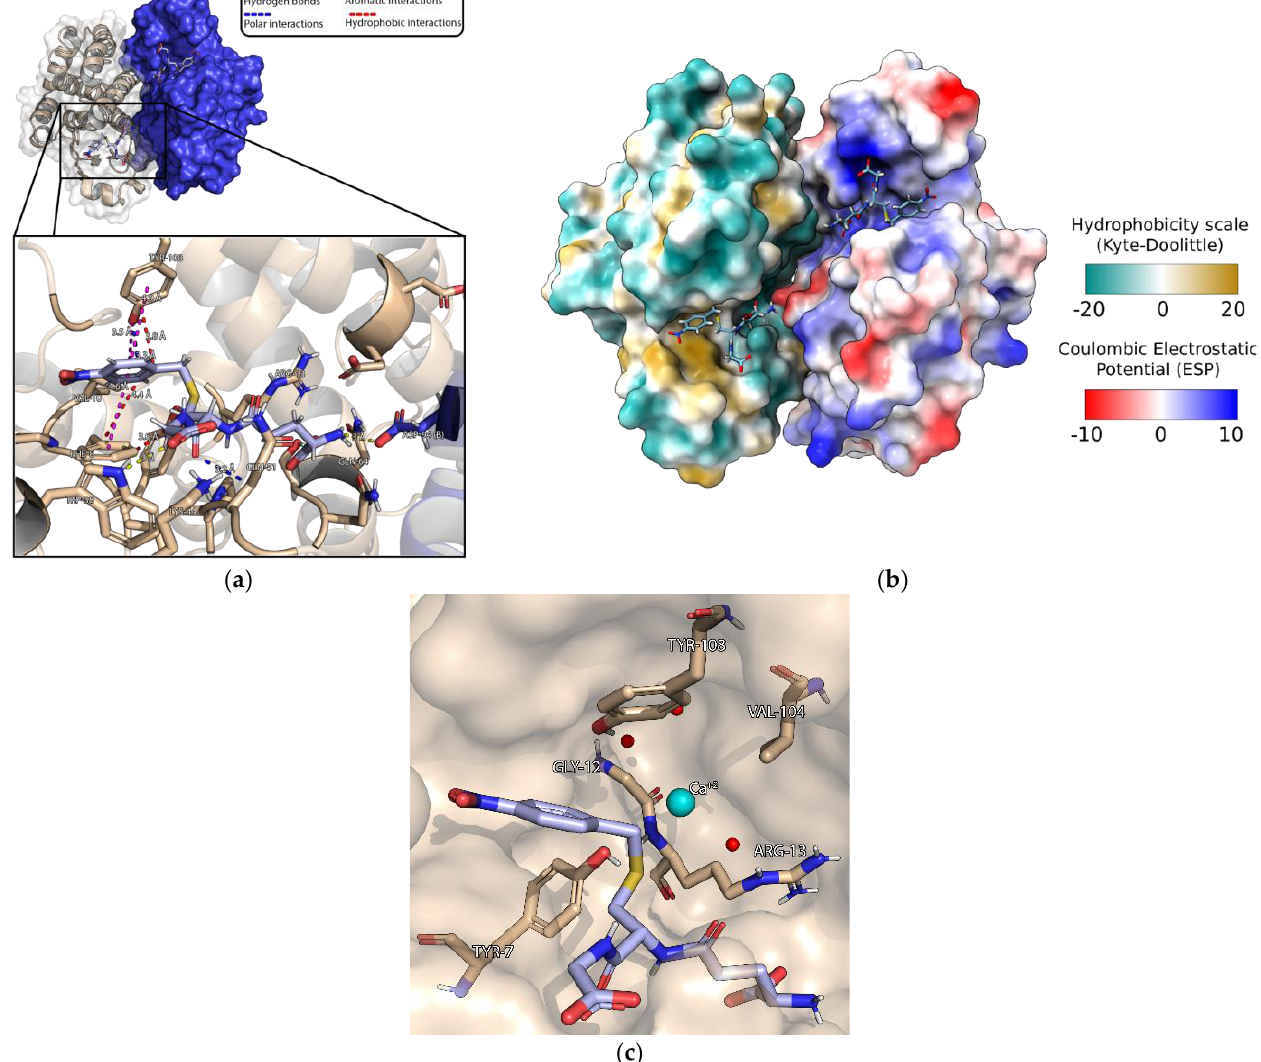
Figure 6. ( a ) The structure of Mm GSTP1 − 1 at 1.28 Å resolution. Each subunit is shown in a different color. The bound Nb-GSH is shown in a stick representation and colored according to the atom type. The figure was produced using the PyMOL program [39]. Close up: The amino acids that contribute to Nb-GSH binding. The close-up figure was created using PyMOL [39]. Interactions were calculated using the web server Arpeggio [46]. ( b ) The electrostatic and hydrophobicity potential of Mm GSTP1-1. One subunit is colored according to the electrostatic potential. Negative, positive, and neutral charges are shown as shades of red, blue, and white, respectively. The other subunit is colored according to the hydropathic character of the protein [47]. Hydrophilic to hydrophobic residues are colored from pale green to yellow brown. The bound NB-GSH is shown in a stick representation. The figure was created using the UCSF ChimeraX program [48,49]. ( c ) The interactions of the Ca 2+ in the vicinity of H-site with important amino acid residues. Ca 2+ is shown as a green sphere and water molecules as red spheres. Nb-GSH is shown in a stick representation and colored according to the atom type.